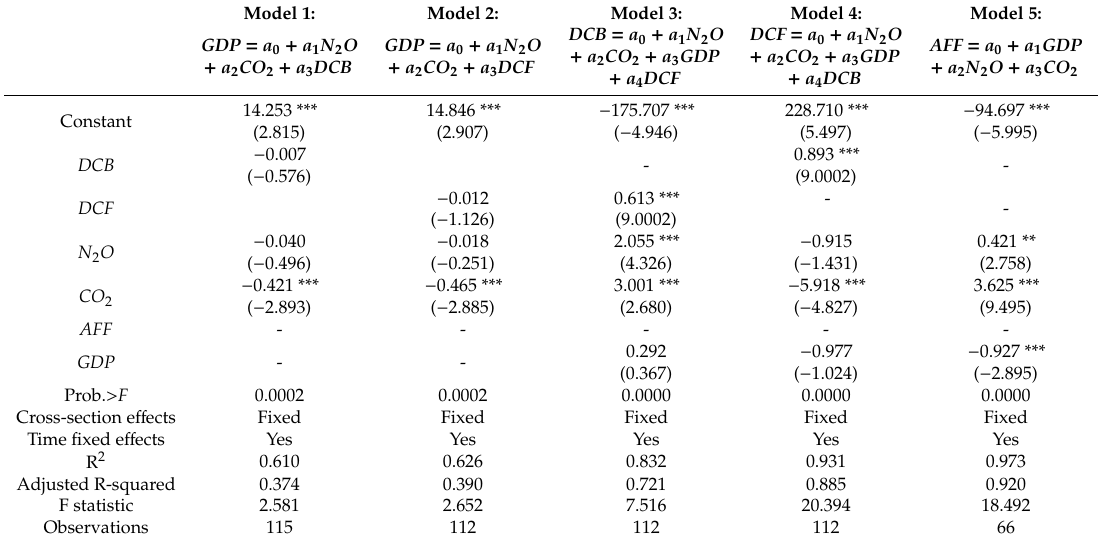
Table 3. Econometric models estimating the relationships between our variables of interest. Model 1: Model 2: Model 3: Model